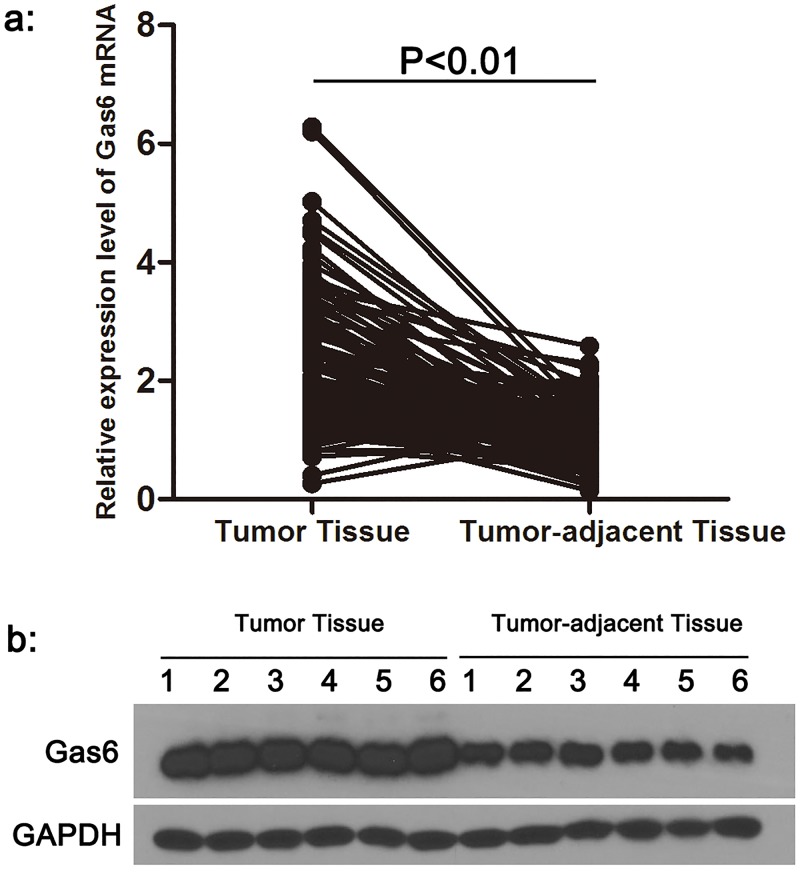
The mRNA and protein expression level of Gas6 between tumor tissue and tumor-adjacent tissue in OSCC patients (a, b).